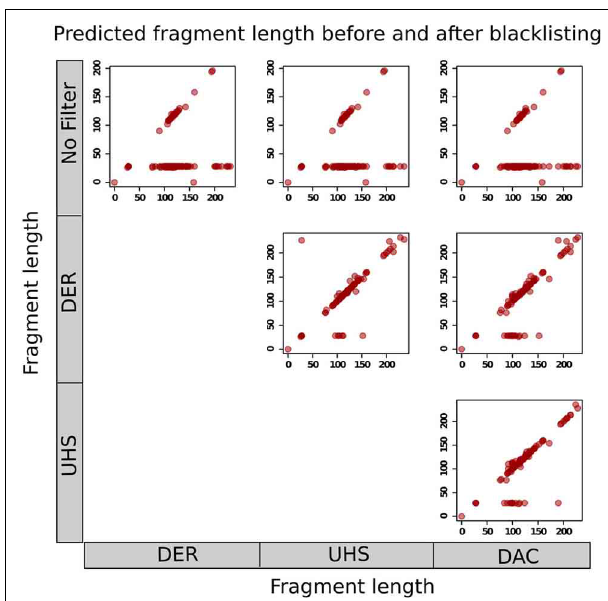
FIGURE 6 | Scatterplots show the fragment lengths predicted by cross-correlation analysis for transcription factor datasets from the ENCODE/SYDH set, with no filtering and following blacklisting by the DAC consensus, UHS, and DER blacklists.